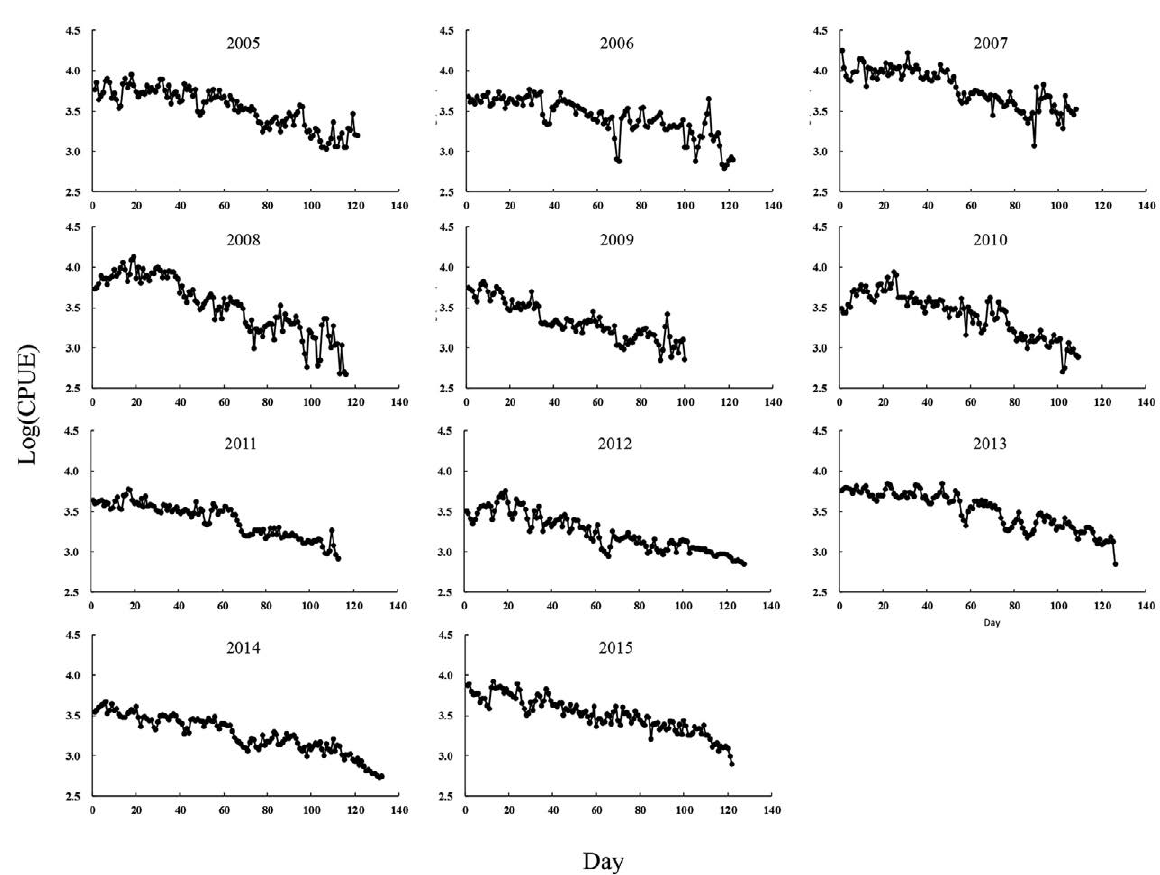
Fig. 4. – Logarithm of standardized daily CPUE (individuals d –1 ) of the Chinese squid-jigging fishery in the Northwest Pacific Ocean from 2005 to